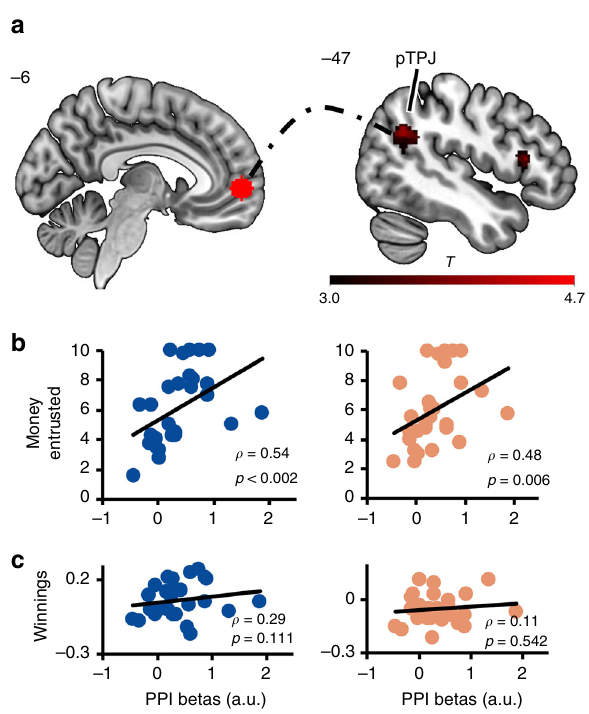
Fig. 5 Task-based functional connectivity analysis. Task-based functional connectivity between the VMPFC and left pTPJ was stronger for honesty than dishonesty ( a ). Critically, this functional connectivity correlated with an individual ’ s willingness to trust in the TG ( b ), but not with one ’ s payoffs in the TAG ( c ) (Spearman ’ s correlations). Blue dots on correlation plots on the left represent behaviors toward honest advisers, orange dots on correlation plots on the right represent behaviors toward dishonest advisers. Each dot represents one participant. VMPFC, ventromedial prefrontal cortex; pTPJ, posterior temporo-parietal junction; PPI, psychophysiological interaction; a.u., arbitary units. Heatmap represents t values